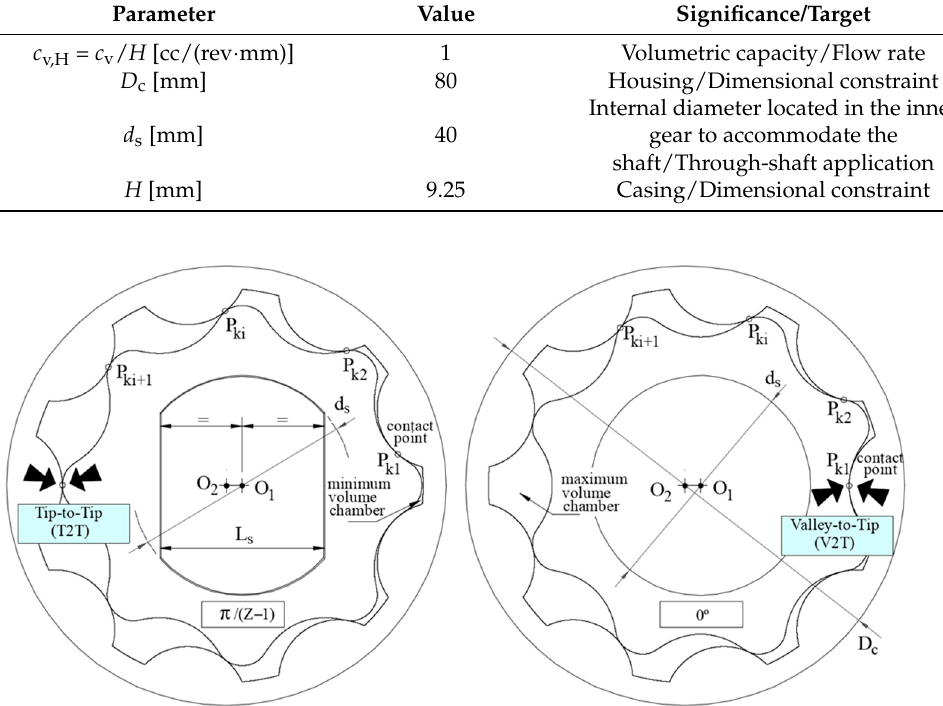
Figure 6. The benchmark gerotor in working function: the Tip-to-Tip (T2T) position (left) and the Valley-to-Tip (V2T) position (right), the shaft keyway (‘yes’ shaft keyway, left) and the shaft hole without keyway (‘no’ shaft keyway, right).